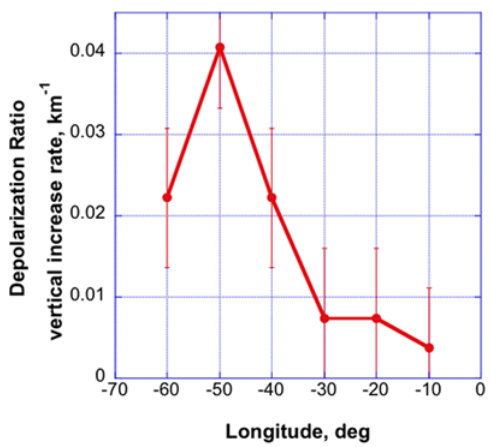
Fig. A4. Rate of vertical increase in dust particulate depolarization ratio between 3 and 4km altitudes, vs. distance from the African coast. This corresponds to the Fig. 6.